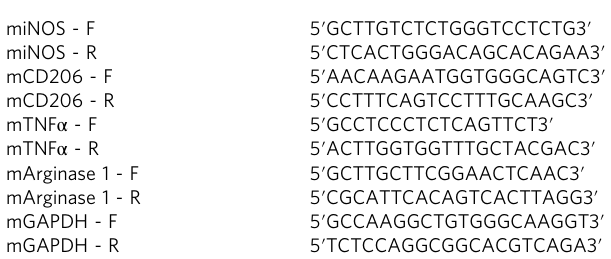
Table 1 Primer sequences for the qPCR analysis conducted on in vivo brain section samples on days 1, 3, 5, and 7 after a major hemorrhagic